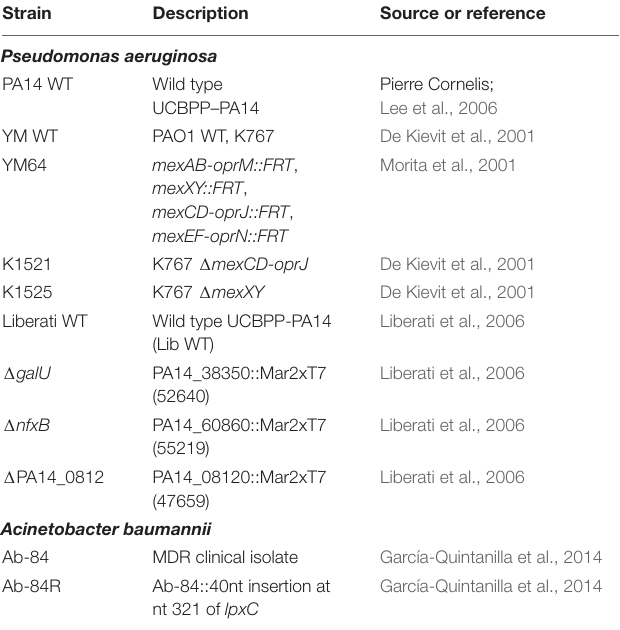
TABLE 1 | Strains used in this